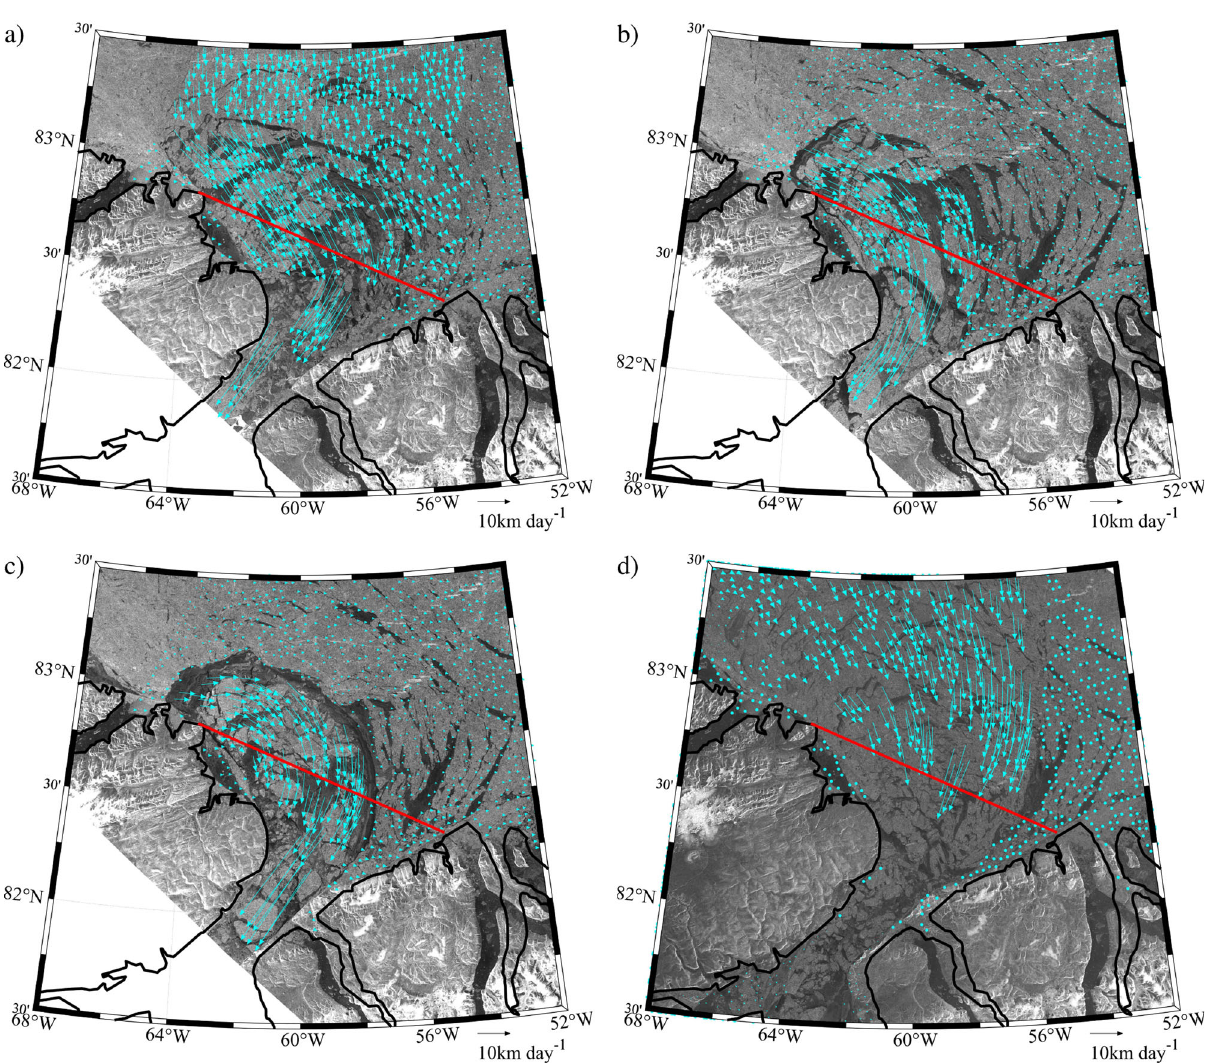
Fig. 5 Lincoln Sea ice motion during 2019. Sentinel-1 SAR satellite images and derived sea ice motion vectors (km day -1 ) on: a January 14 2019 at 18:55 GMT GMT; b February 7 2019 at 18:55GMT; c February 19 2019 at 18:55 GMT; and d March 27 2019 at 12:33 GMT. The southern Lincoln Sea fl ux gate used to calculate the ice area fl ux is shown in